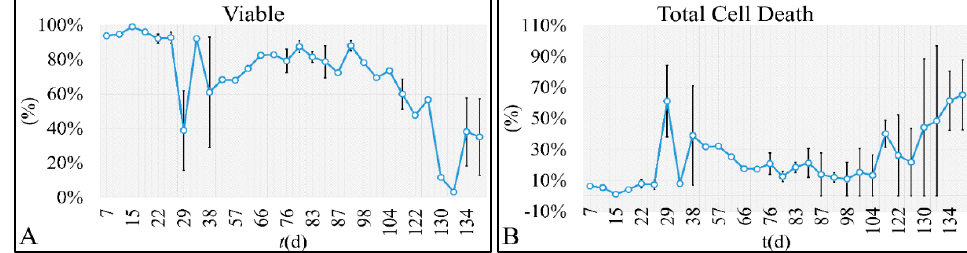
Figure 7 . The time-series presentation of the cell population’s viability ( A ) and total cell death ( B ) of the CCRF-CEM cells.